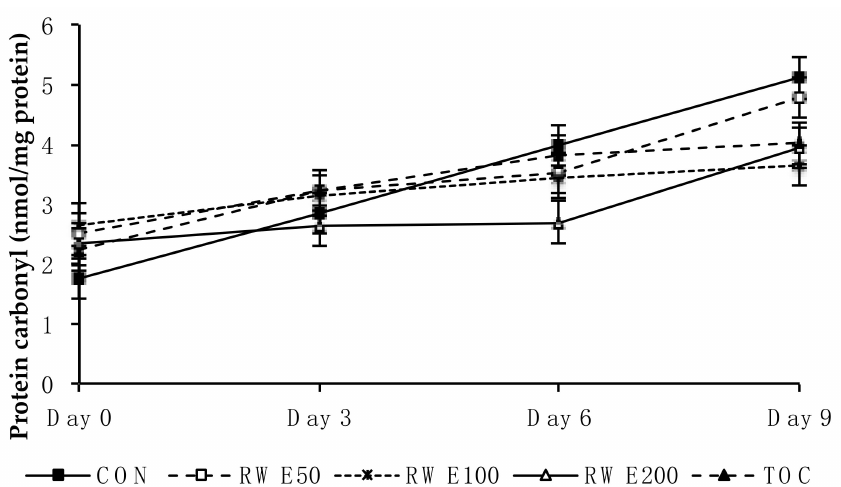
Figure 2. Protein oxidation (carbonyl groups) measured in n -3-enriched lamb meat patties over the 9-day storage period in high oxygen modified atmosphere packs (HiOx-MAP), containing different levels of antioxidants. CON: control without antioxidant; RWE50: 50 mg GAE/kg muscle; RWE100: 100 mg GAE/kg muscle; RWE200: 200 mg GAE/kg muscle; TOC: 100 mg -tocopherol/kg muscle. Data are expressed as mean value ± standard error of three replicates in triplicate.